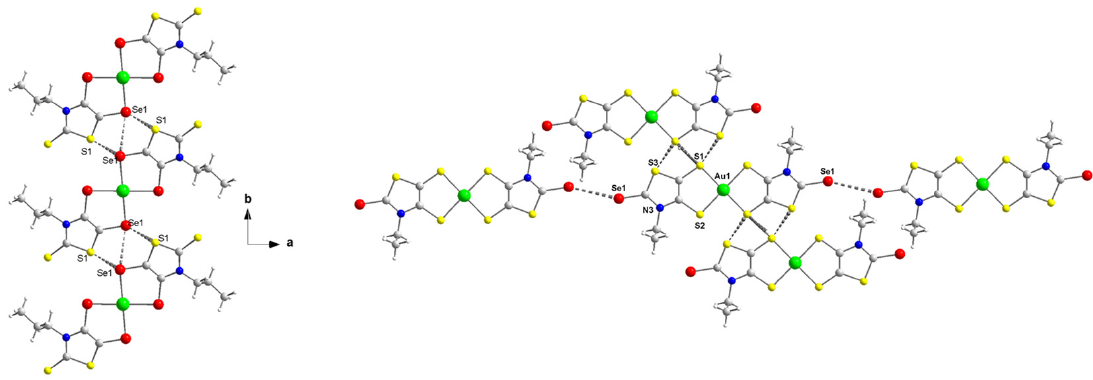
Figure 2. View of the chalcogen•••chalcogen short contacts between neighboring monoanionic